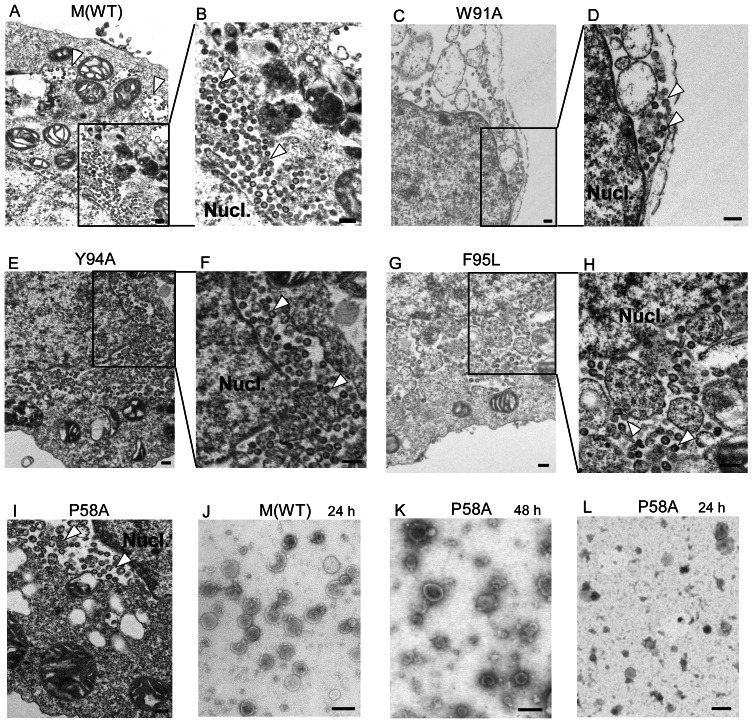
SARS-CoV VLP analysis.293T cells were cotransfected with SARS-CoV N and wt or indicated M mutant plasmid. At 48 h post-transfection, cells and supernatants were collected. Cells (panels A to I) were fixed and prepared for electron microscopy analysis as described in Material and Methods. Supernatants (panels J to L) were filtered and pelleted through 20% sucrose cushions, resuspended in PBS buffer and stained. Cell and supernatant samples were observed with a transmission electron microscope. The high-power view in the inset shows VLPs near cell nuclei (arrowheads). Bars, 100 nm.